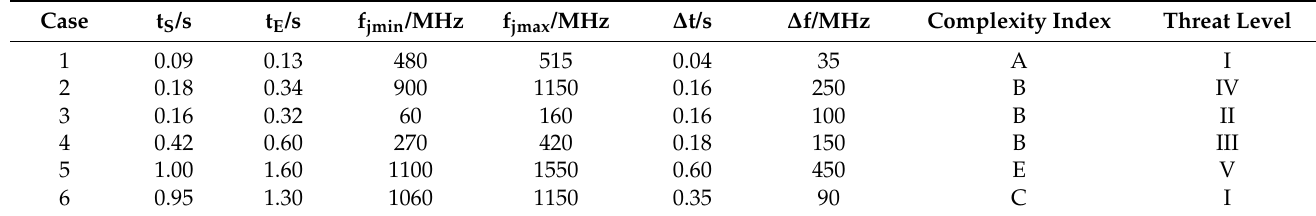
Table 4. Interference level of electromagnetic radiation caused by rocket